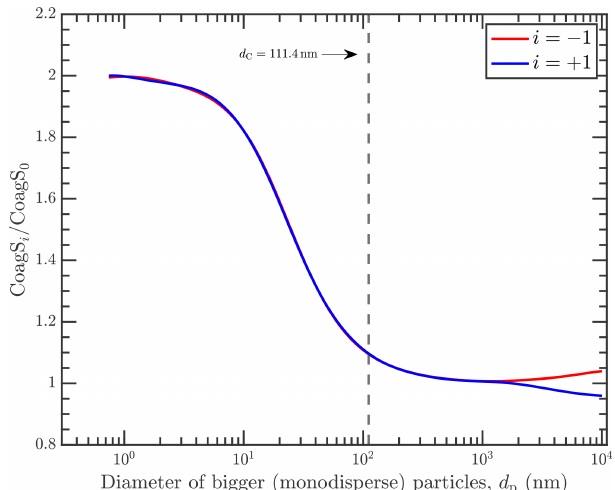
Figure 2. The ratio of the coagulation sink of charged ( i = ± 1) to neutral nucleating particles (modeled as primary ions). The colors refer to the charge of the primary ions: red is negative and blue is positive. Also shown is the Coulomb diameter, d C , at 111.4nm. For d p (cid:28) d C , the coagulation sink for charged particles approaches a limit of twice the coagulation sink for neutral particles.